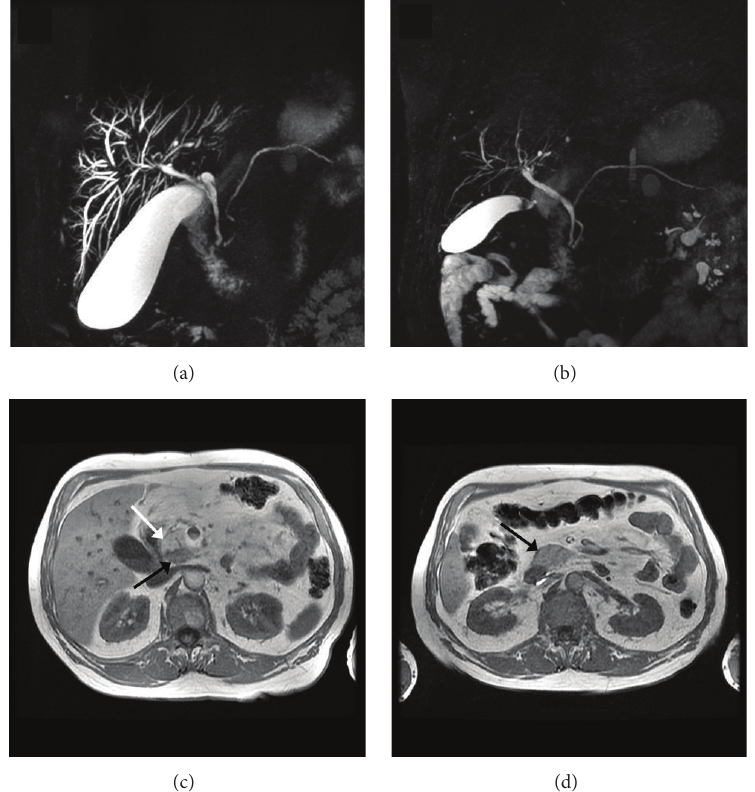
Figure 1: MRCP findings: Case 1 . (a) Narrowing and stricture of the common bile duct with dilated intrahepatic ducts. (b) Resolution of intrahepatic duct dilation and CBD narrowing after steroid therapy. (c) 2.7 cm hypointense lesion in the pancreatic head (black arrow) near a region of normal pancreatic parenchyma (white arrow). (d) Resolution after steroid therapy. The pancreatic parenchyma is homogeneous and isointense with the adjacent